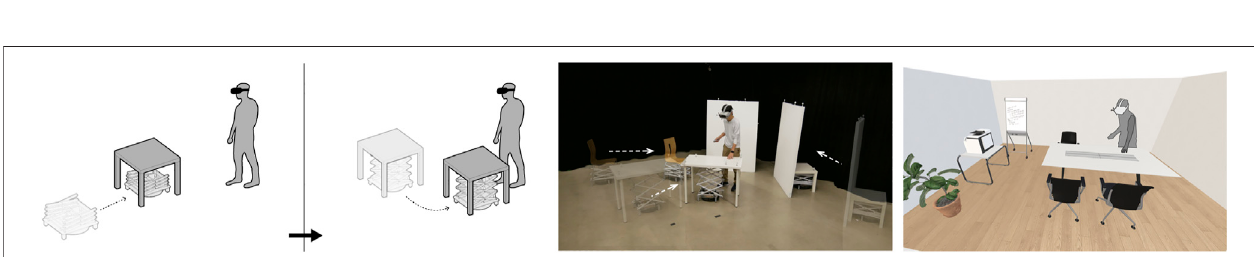
FIGURE7| RoomShiftiscomprisedofaswarmofshape-changingrobotsthatprovidehapticfeedbackinVRbymanipulatingphysicalfurnitureandwalls.Multiple robots move environmental objects to collectively construct and adapt a physical haptic environment that matches virtual scenes. Above, we show the physical environment with a corresponding virtual scene, with a human silhouette added for a reference.